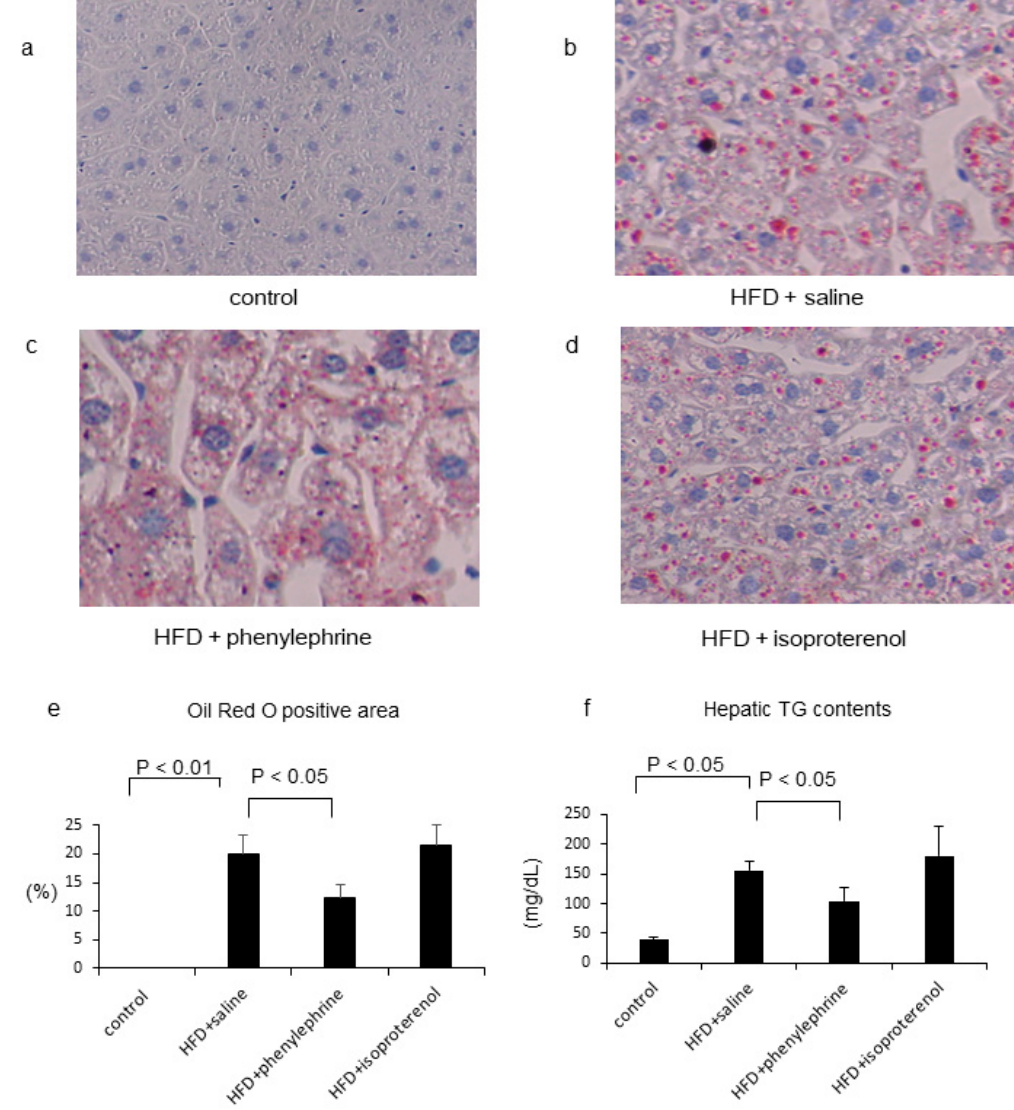
Figure 1. Representative images of liver tissues stained with Oil Red O. Mice were fed with control diet ( n = 5) ( a ), high-fat diet (HFD; n = 6) ( b ), HFD with phenylephrine ( n = 6) ( c ), or HFD with isoproterenol ( n = 7) ( d ). Original magnification, 100 × . The Oil Red O-positive area was quantified in five randomly selected fields per section ( e ). The percentage of Oil Red O-positive area was measured with a computerized image analysis system using Image-Pro Plus version 4.5. Hepatic triglyceride (TG) contents (mg / dL) in the respective groups ( f ). Statistical analysis was performed using analysis of variance (ANOVA). Data are expressed as means ± standard error